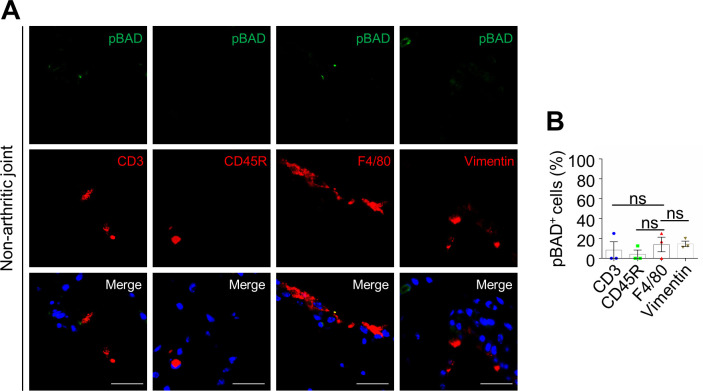
pBAD staining in various cell types of non-arthritic joints.(A) Double staining of anti-pBAD(S136) with T cell marker anti-CD3, B cell marker anti-CD45R, macrophage marker anti-F4/80 or synovial fibroblast marker anti-Vimentin, respectively, in the synovium of WT non-arthritic mice. Scale bar, 25 μm. (B) Quantification of percentages of pBAD(S136) positive cells in total cells per field of different cell types (n = 3). Data are presented as mean ± SEM; dots represent individual mice. Significant difference was analyzed by one-way ANOVA test.